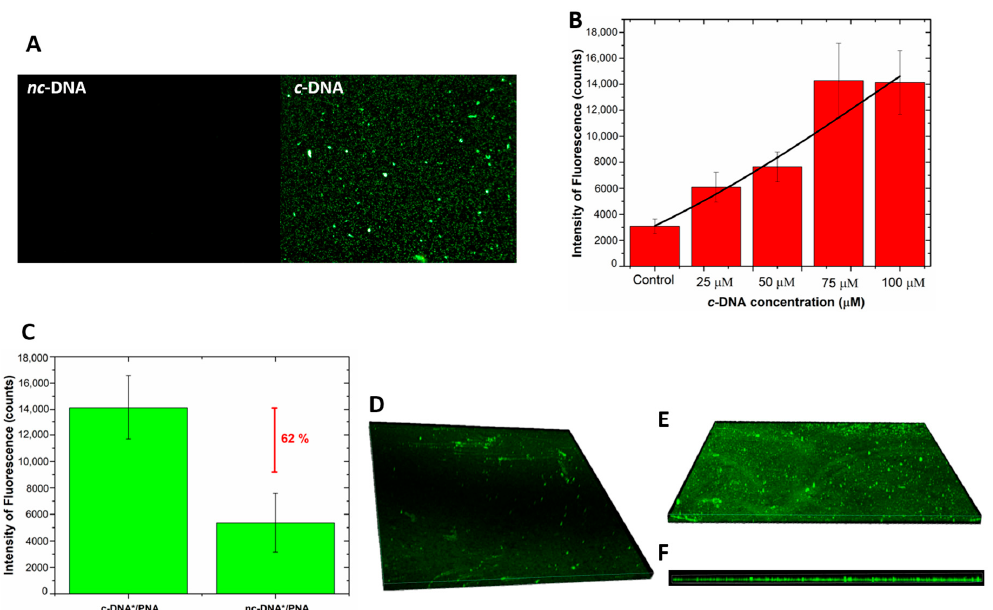
Figure 8. ( A ) fluorescence images of PNA-GO/PSi device incubated with fluorescent DNA (c-DNA) and DNA polyT (nc-DNA) at magnification 50×; ( B ) fluorescence intensity as a function of c-DNA concentration. The values were calculated by averaging different images of the same sample. Data were fitted by using OriginLab TM Dose–response non-linear curve fit; ( C ) comparison between fluorescence intensity values of PNA-GO/PSi device after the interaction with 100 µM of fluorescent c-DNA (c-DNA*) and 100 µM of fluorescent nc-DNA (nc-DNA*); ( D ) top view of the fluorescent DNA infiltrated in the GO/PSi device (negative control); ( E ) top view and ( F ) side view of PNA/DNA infiltrated into PSi.